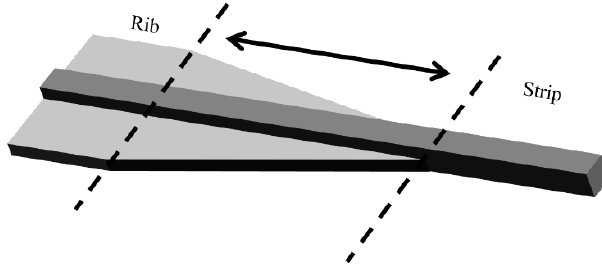
Figure 2. 3D schematic of a rib-strip transition.